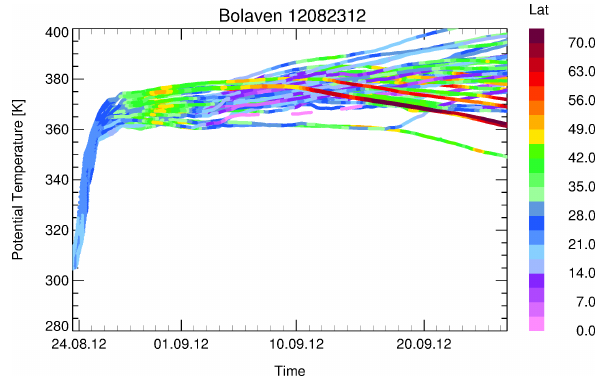
Figure 6. Selected forward trajectories starting in the boundary Fig.6. SelectedforwardtrajectoriesstartingintheboundarylayeraroundthepositionofthetyphoonBolavenon23August201212:00UTC